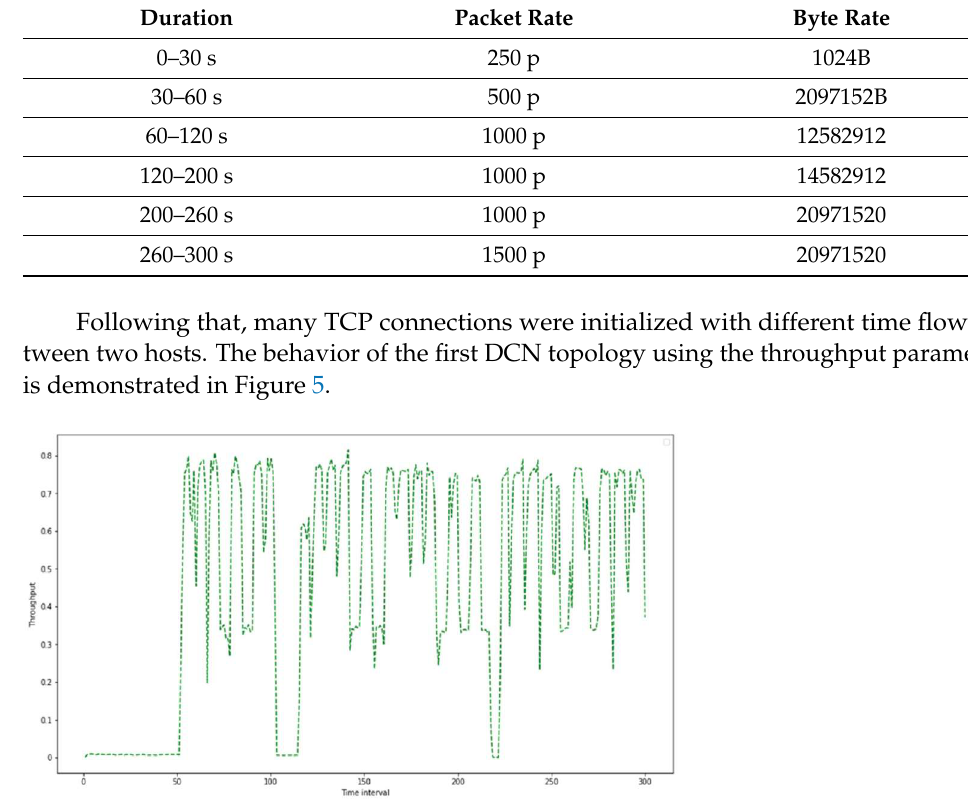
Figure 5. Throughput of the Network During 300 s of Simulation.